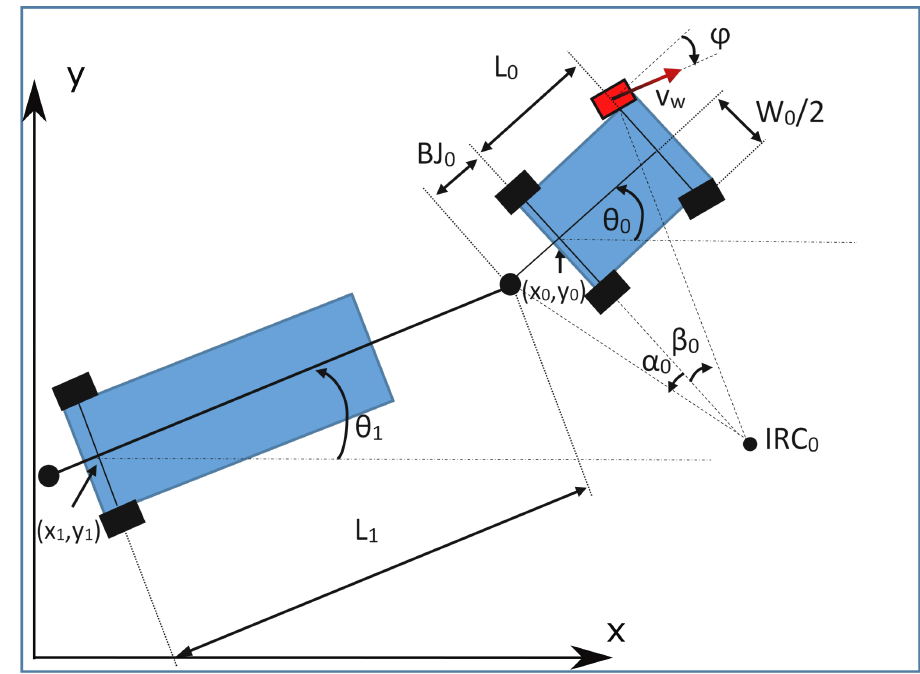
Figure 5. Simple trailer